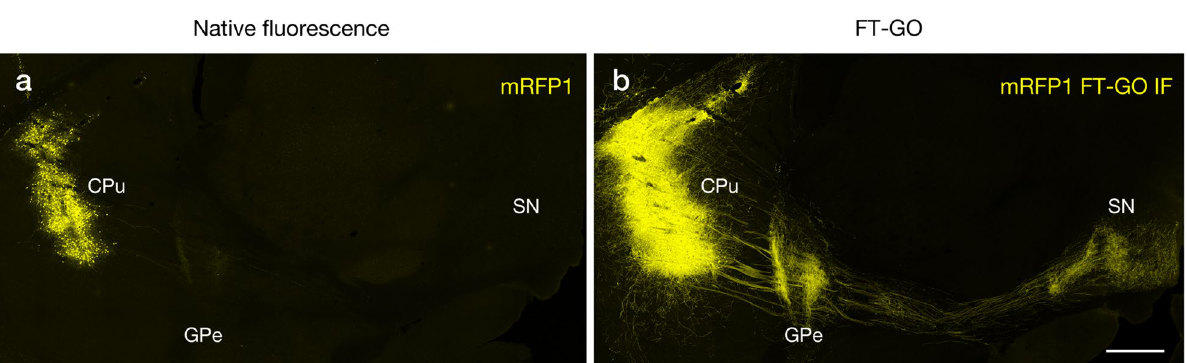
Figure 7. Neuroanatomical tract tracing combined an anterograde AAV tracer with FT-GO IF. (a,b) mRFP1 native fluorescence ( a ) and RFP FT-GO IF ( b ) in mouse parasagittal brain sections with an injection of AAV2/1- SynTetOff-mRFP1 (n = 4 injection sites from 2 animals). ( a,b ) are adjacent sections. CF568 tyramide is used for color development. CPu caudate-putamen, GPe external segment of the globus pallidus, SN substantia nigra. Scale bars: 500